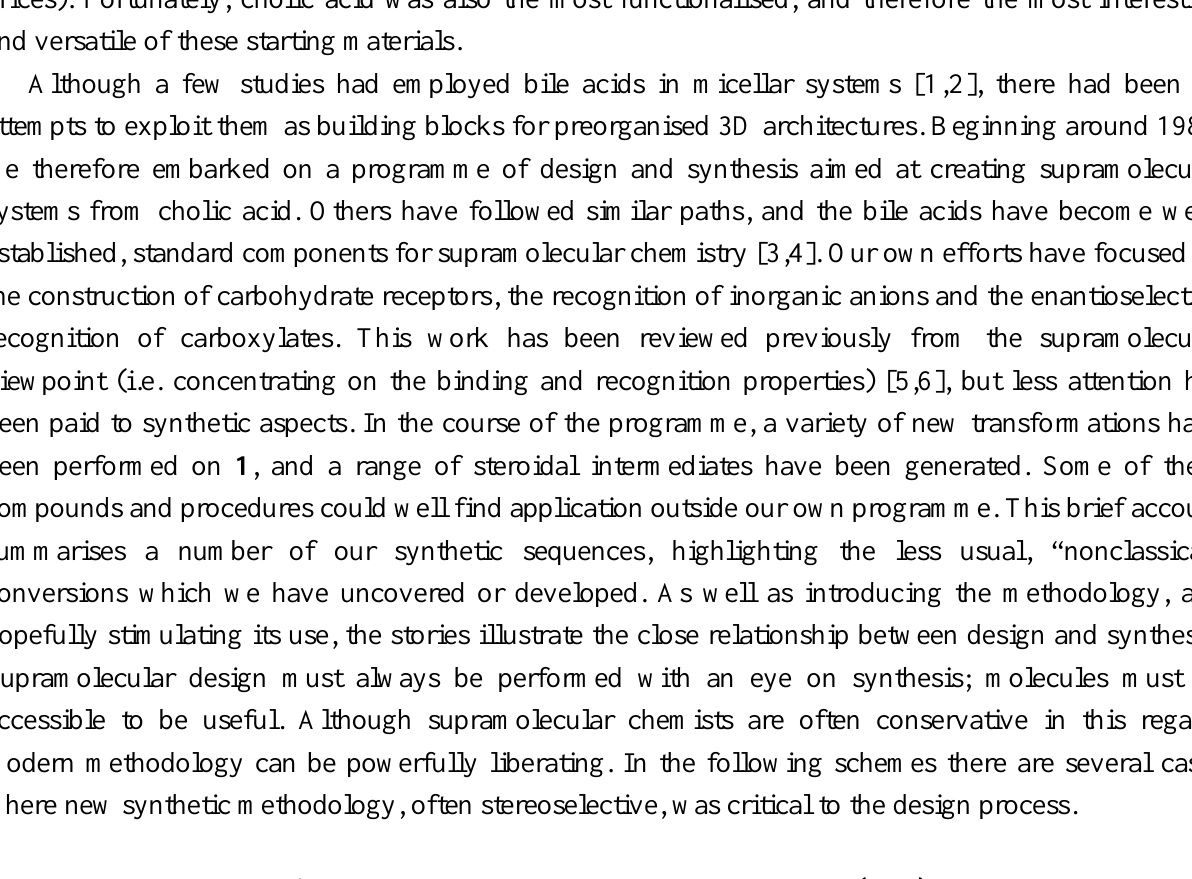
Figure 1. Cholic acid 1 with numbering system